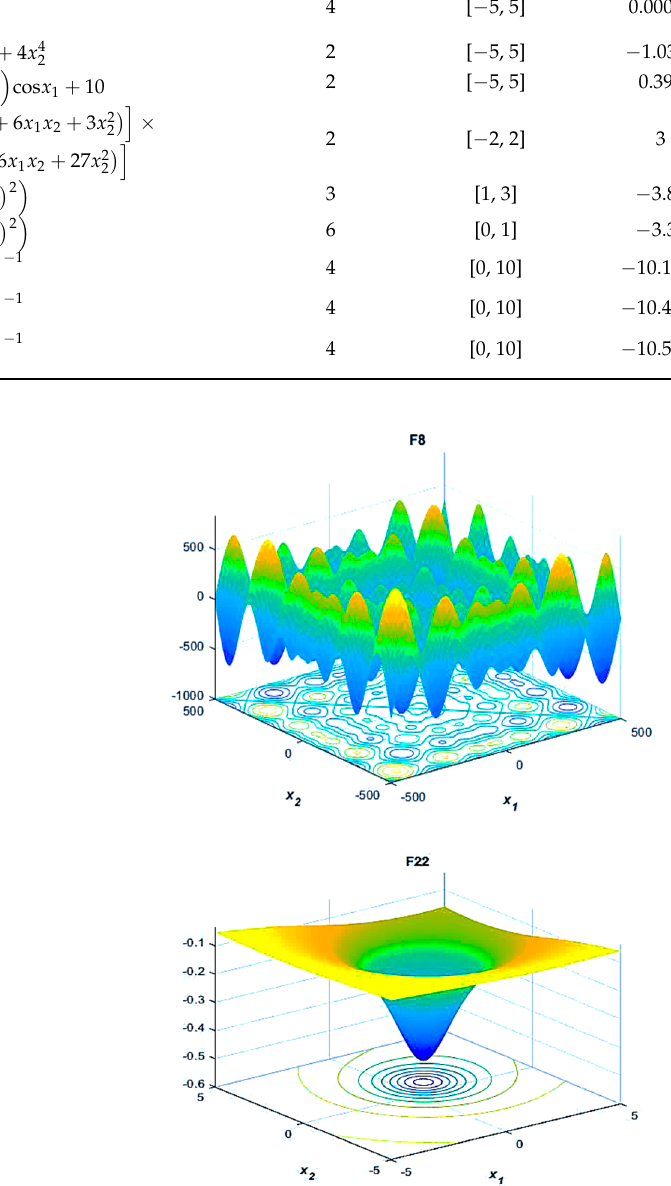
Table 3. Description of fixed-dimension multimodal benchmark functions ( F 14 − F 23 ). Function Dim Range f min (cid:18) 1 + Σ 25 F 14 ( x ) = j = 1 500